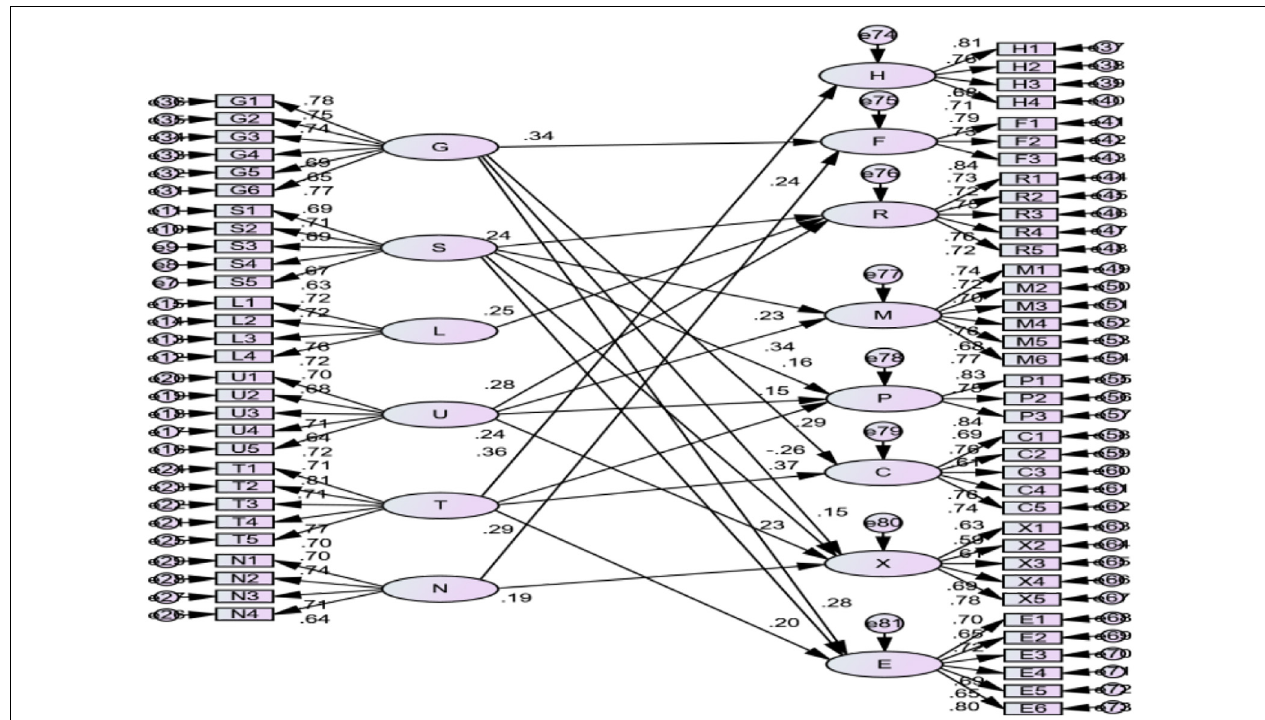
FIGURE 5 | Modified structural equation model.